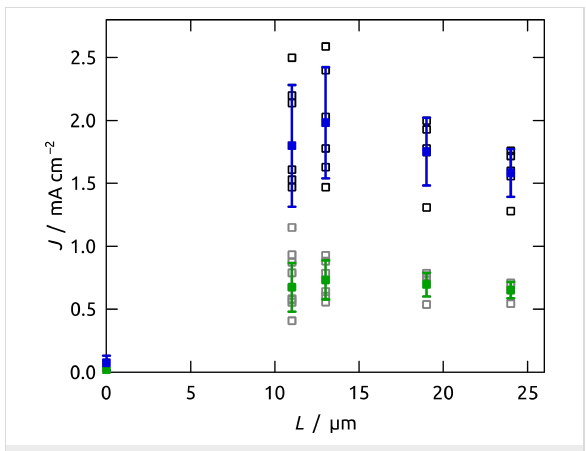
Figure 12: Current densities of Ru/C electrodes for water oxidation measured at pH 4 and at 0.10 V or 0.20 V applied overpotential. The current densities J are presented for individual samples in gray ( η = 0.10 V) and black ( η = 0.20 V), whereas the full green and blue squares correspond to the average values.